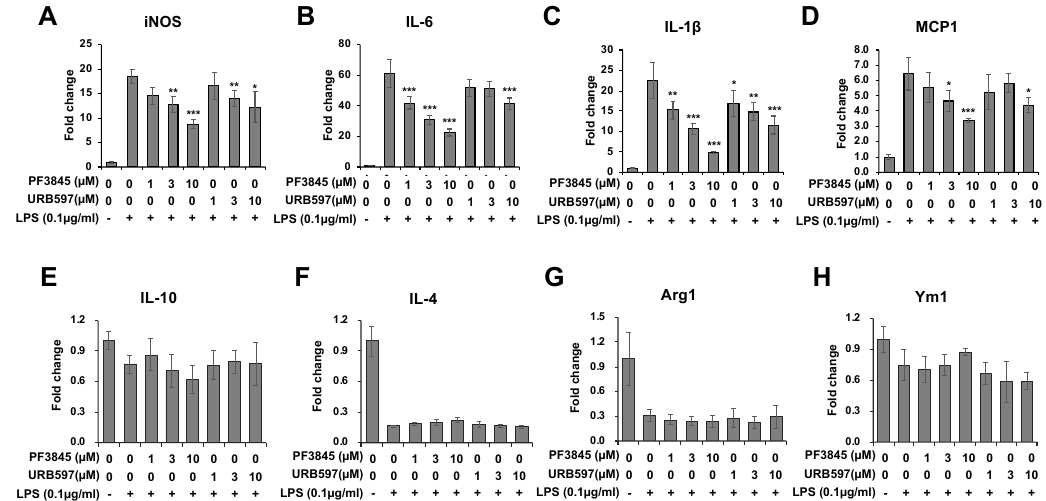
Figure 4. Regulation of pro-inflammatory and anti-inflammatory genes by FAAH inhibitor. BV2 cells were treated with LPS and inhibitor for 8 h. Total RNA from the cells was used for qRT-PCR to measure the expression levels of the pro-inflammatory genes, iNOS ( A ), IL-6 ( B ), IL-1 β ( C ), and MCP-1 ( D ), as well as the anti-inflammatory markers, IL-10 ( E ), IL-4 ( F ), Arg1 ( G ) and Ym1 ( H ). The + and – symbols indicate the presence or absence, respectively, of LPS. Data are presented as means ± S.D. (n = 3). *, **, and *** denote p < 0.05, p < 0.01, and p < 0.001,